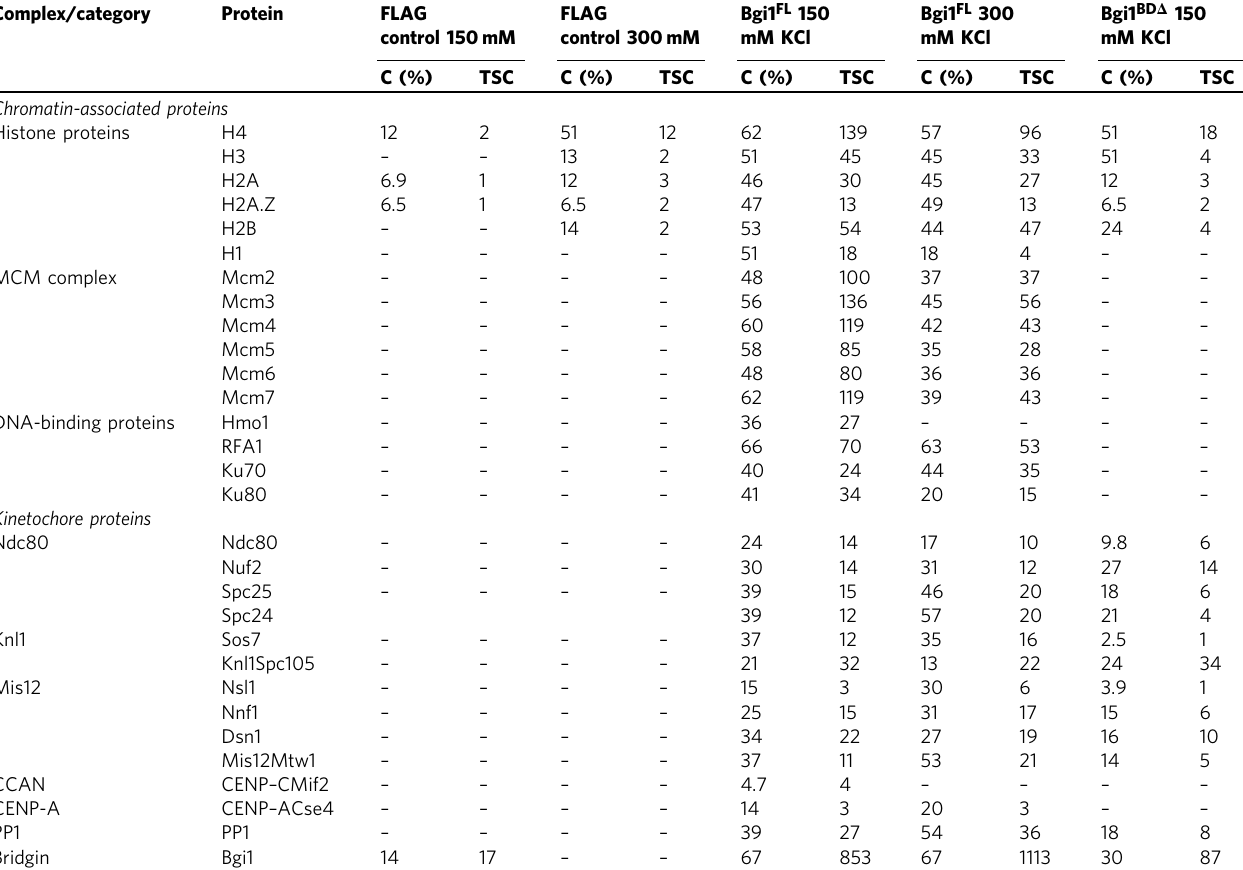
Table 2 List of chromatin-associated and kinetochore proteins obtained as interactors from bridgin IP ’ s performed in Fig. 5a.